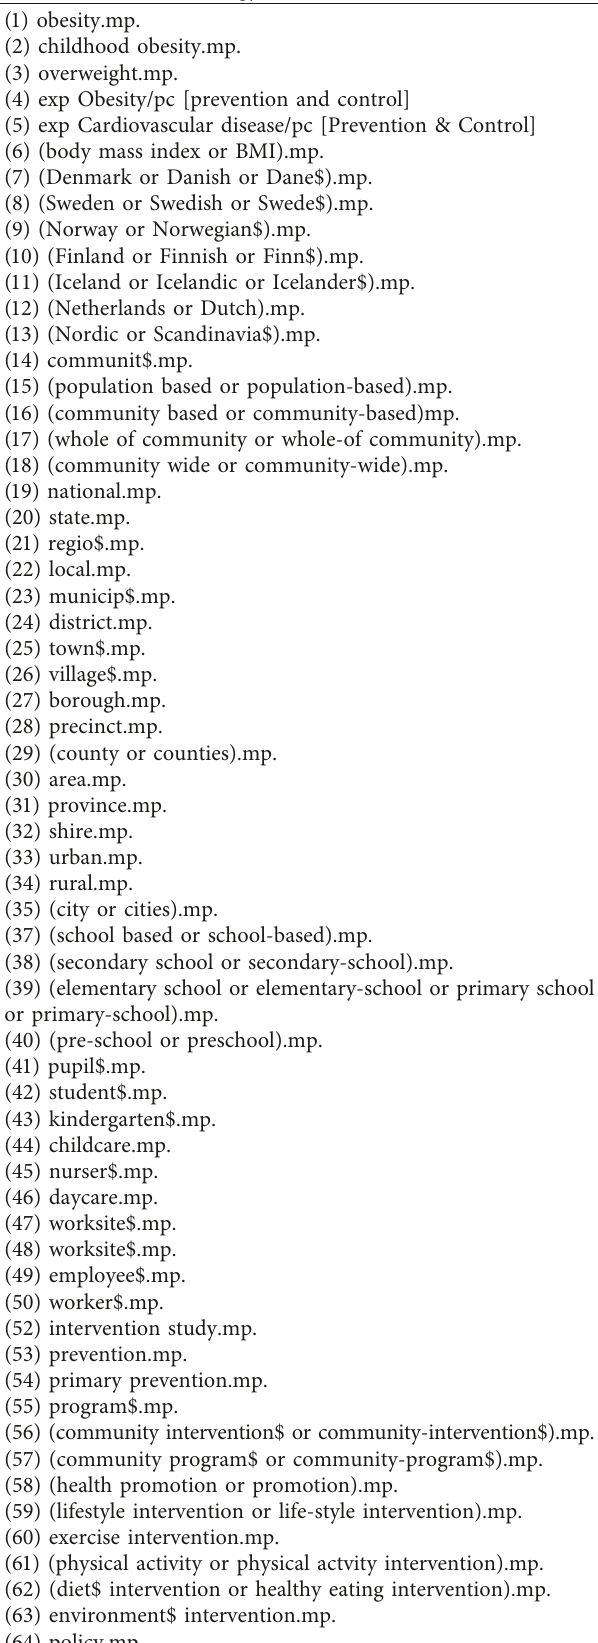
Table 1: Search strategy, medline and EMBASE via